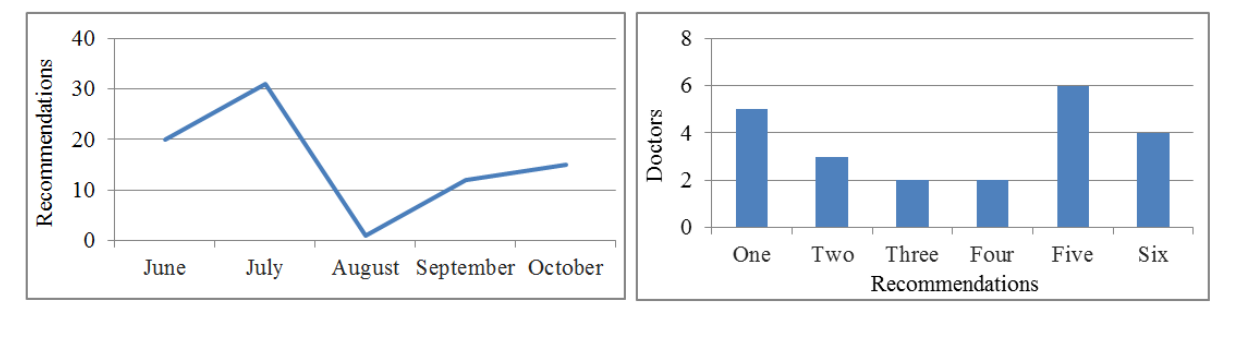
Figure 3. Monthly recommendations and number of recommendations per professional.